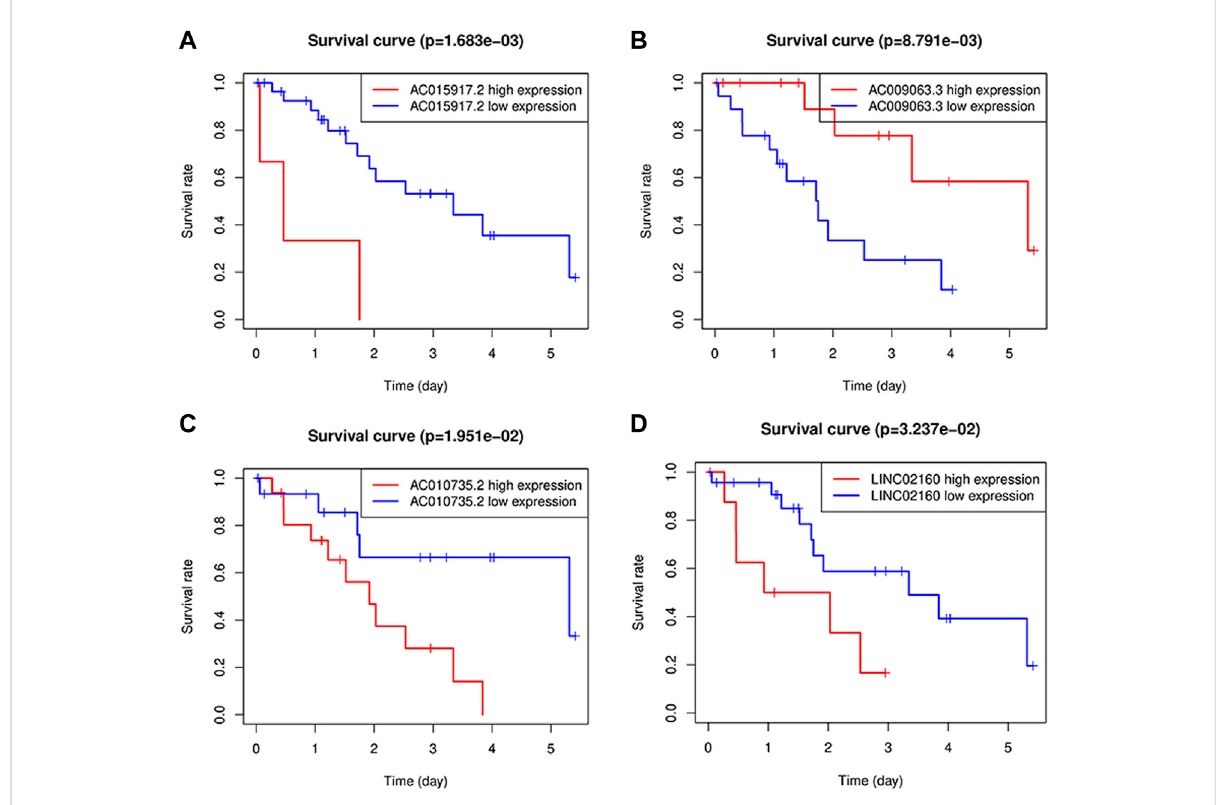
FIGURE 6 Kaplan-Meier survival analysis of four lncRNAs; (A-D) : Survival curve, where AC015917.2 AC010735.2, LINC02160 high expression, AC009063.3 patients with low expression of iCCA OS is